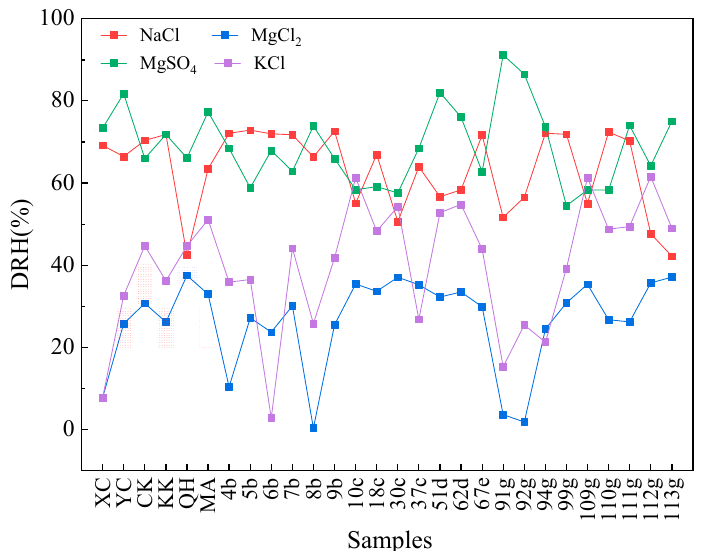
Figure 5. AIOMFAC modeled DRHs of four salt components in brine samples. b from [42], c from [43,44], d from [45], e from [46], g from [47,48]. The red and blue squares in Figure 5 indicate the RH onsets for initial and significant water uptake that are experimentally observed, respectively. The experimental results of the six original samples are presented in Figure 6. Figure 6a–c show the growth factors as a function of RH, and Figure 6d shows the RH of water uptake onsets. In Figure 6a, the dashed lines indicate the theoretically predicted DRHs NaCl in the six samples. The dotted lines in Figure 6b are the calculated DRHs MgCl . To visualize the initial mass change due to water update, Figure 6c zooms in on the y-axis. Identified initial water uptake onsets are indicated as red squares in Figure 6d (same as the red squares in Figure 5). Since mixtures have complicated components that result in complex water update behaviors, most of the samples show continuous mass increases along with the increasing RH. Nevertheless, the XC and QH samples present identifiable major water uptake onsets, which are indicated as blue squares in Figure 6d, the same as the blue squares in Figure 5.